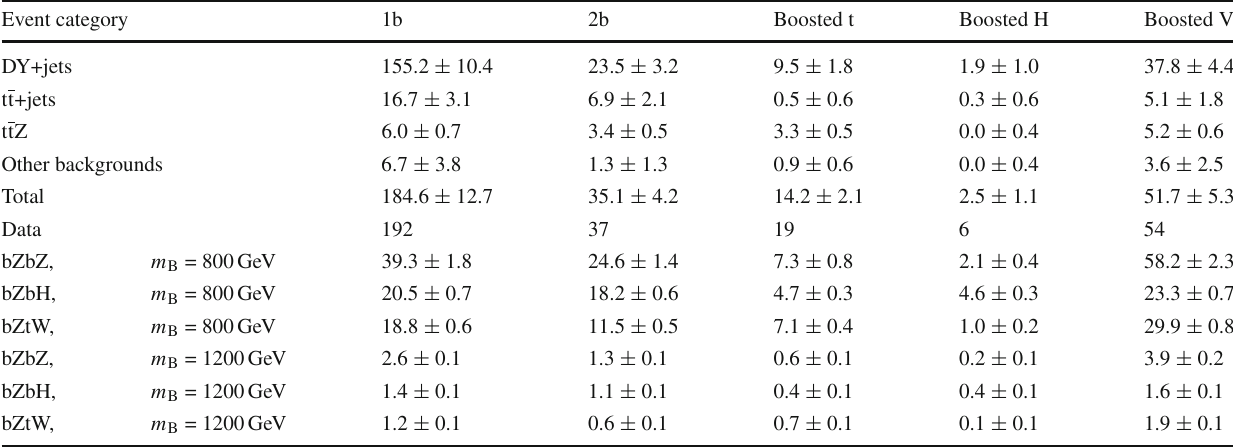
Table 8 The numbers of observed events and the predicted number of SM background events in the BB search for the five event categories using Z → e + e − channel. The expected numbers of signal events for B masses of 800 and 1200GeV with branching fraction hypotheses for the three decay channels, B ( B → bZ ) = 100% (bZbZ), B ( B → bZ ) =